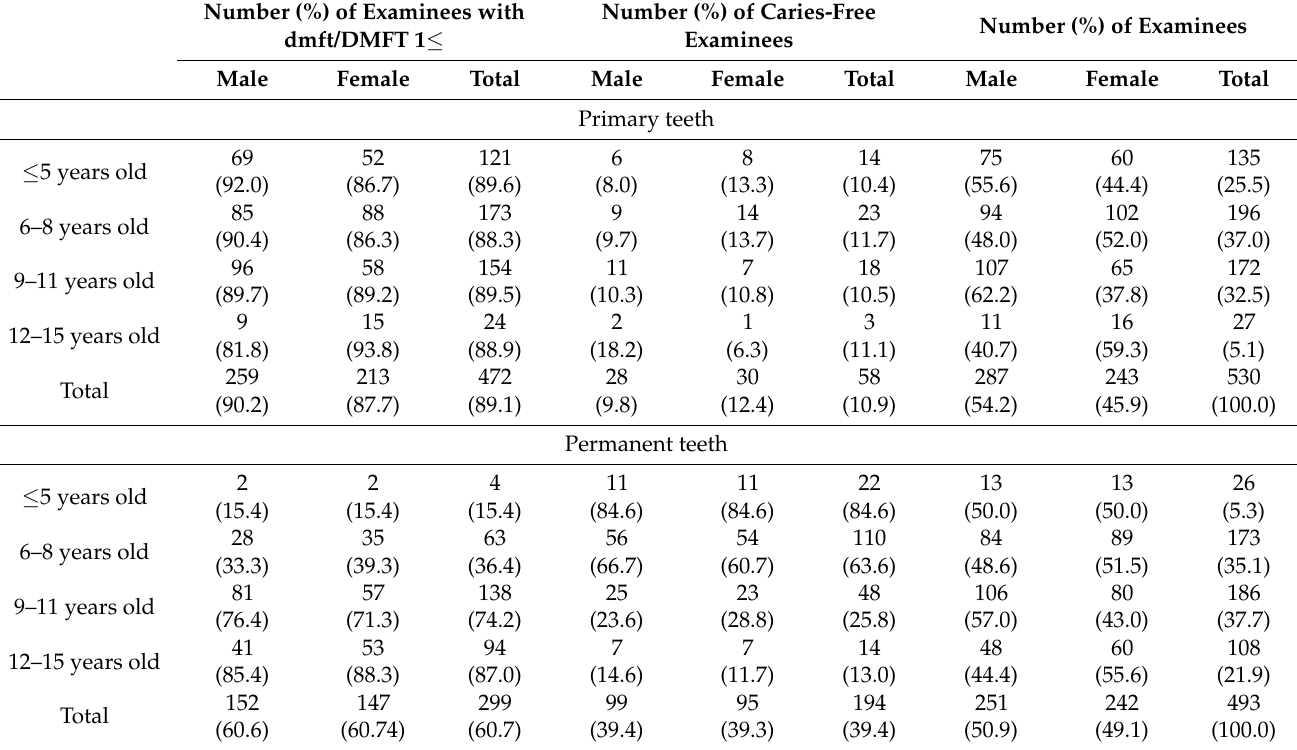
Table 1. Distribution of the examinees according to the study groups.